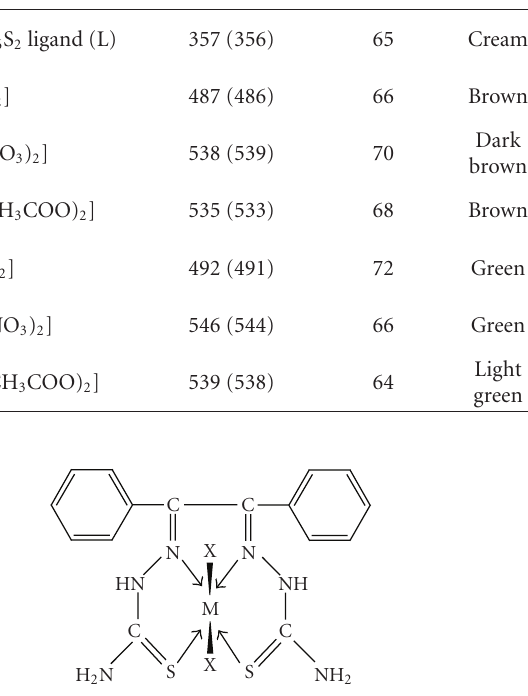
Figure 2: Suggested structure of the complexes.